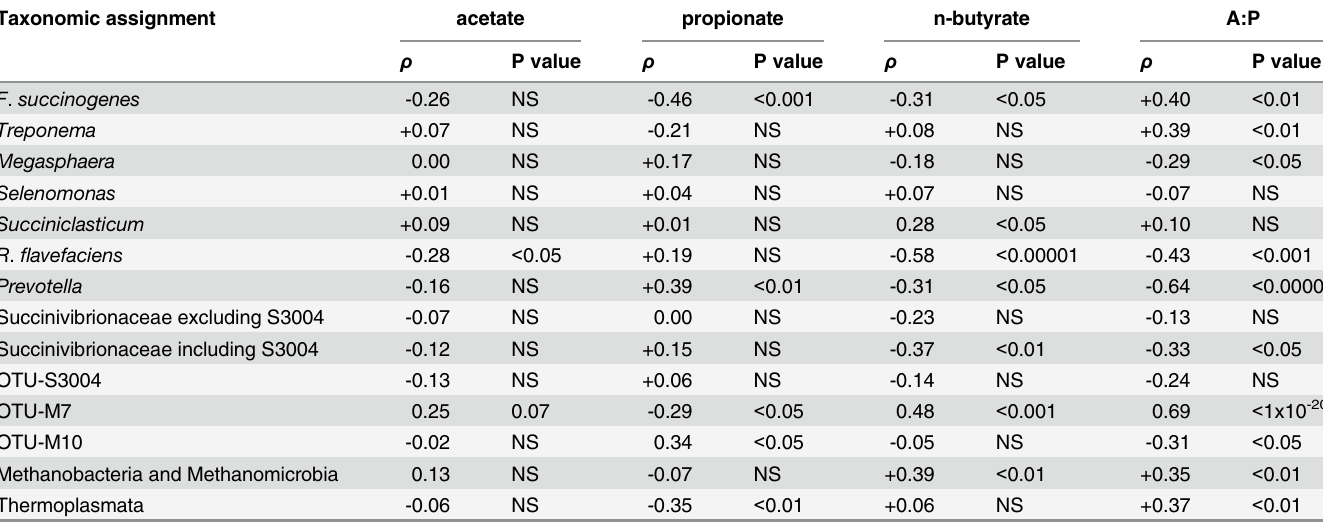
(solid and liquid fractions) showed significant positive correlations with propionate plus signif- icant negative correlations with A:P ratio. OTU-S3004 (liquid fraction) showed the most signif- icant and strongest negative correlation with A:P ratio which further suggests that OTU-S3004 may be a producer of succinate and/or propionate in the rumen of cattle. Table 2. Spearman correlation analysis between VFA and OTU-S3004, methanogenic archaea, and S and P producers in solid rumen samples. Taxonomic